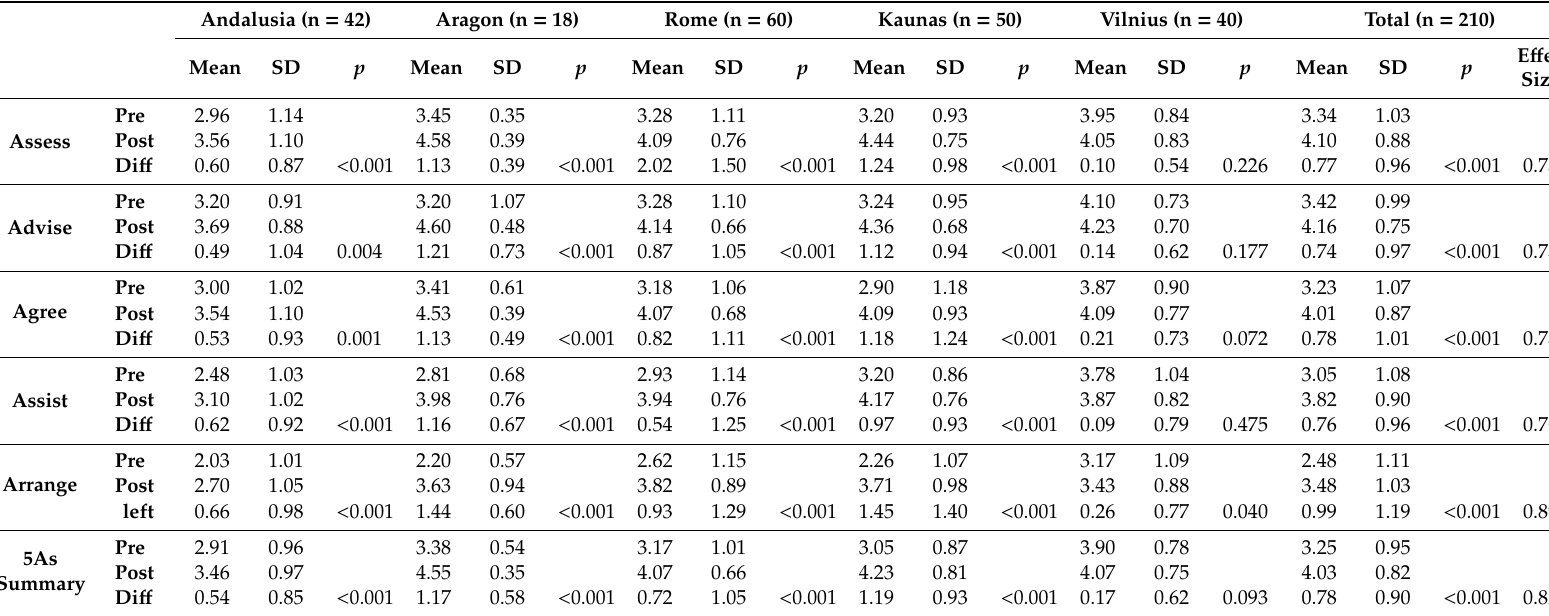
Table 3. Mean scores of Patient Assessment of Care for Chronic Conditions (PACIC + ) survey subscales and total scale, before (pre) and after (post) implementation, by